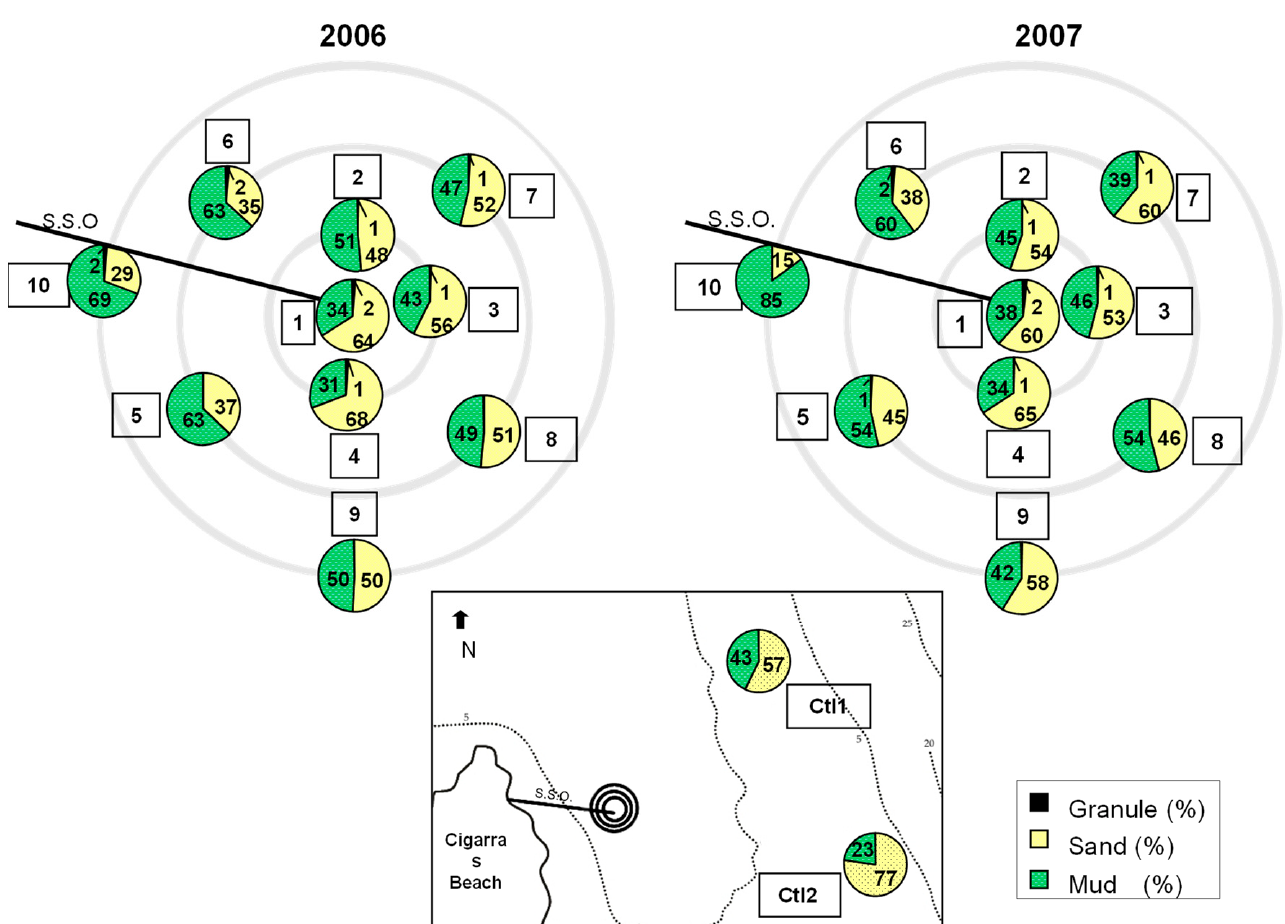
Figure 2. Grain size distribution of sediment samples near the Cigarras submarine outfall. Legend: S.S.O.—sewage submarine outfall. The numbers inside the rectangle represent the stations and the numbers in the graphics are the percentage of granules, sand, and mud fractions. Carbonate contents were similar during both years with the lowest values observed at Cig4 (about 11%) and the highest at Cig10 (about 23%). Patterns of TOC, S, N, C/S, and C/N were similar in 2006 and 2007. The lowest values of TOC, N, S, C/S, and C/N were found near the sewage outfall and the highest values in the north, west, and east directions of the outfall (Figures S2 and S3). ◦ The average values recorded for temperature and salinity were, respectively: 23.3 C/ ◦ ◦ 36.70 at the surface; 23.2 C/ 36.85 in the middle water column; and 22.5 C/36.95 near the bottom. In station CTL1, lower values of salinity and turbidity were recorded than in CTL2 (Table S1). The water turbidity oscillated from 2 NTU (at the surface) to 2.8 NTU (near the bottom). The station CTL1 presented oxygen concentrations <6 mg/l in the middle and near the bottom of the water column. The oxygen contents were higher in all depths of the water column in the station CTL2. The pH values oscillated from 7.97 to 8.08 (mean 8.04) in both stations (Table